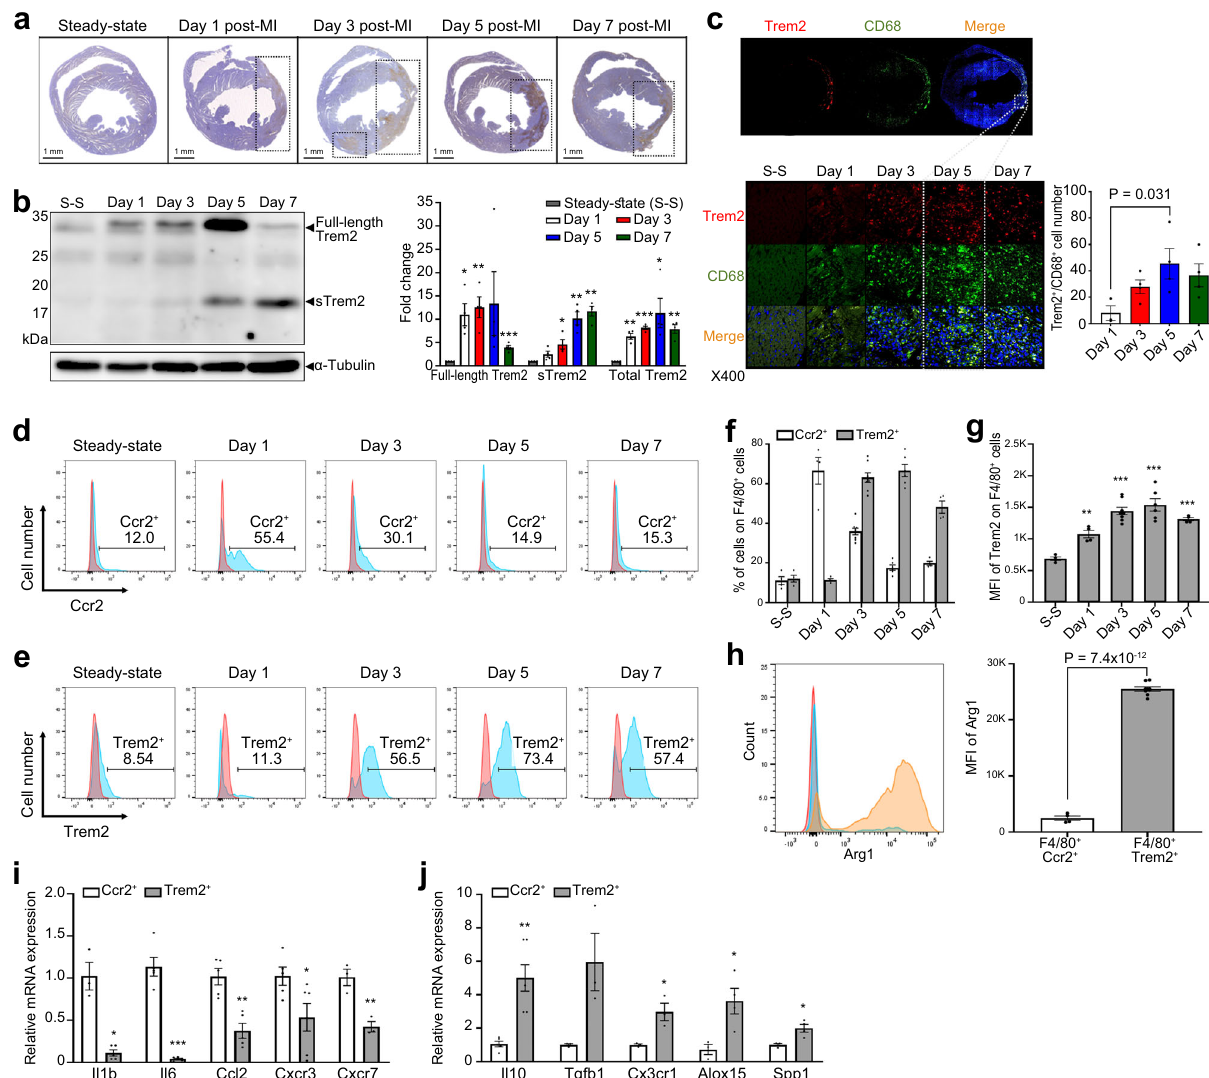
Fig. 5 | Orthogonal validationoftheexpression ofTrem2 in theheart after MI. a Immunohistochemistry showed a gradual increase in the expression of Trem2 over time in the infarcted area after the induction of MI, almost absent in the steady-state. Results are representative of fi ve different samples. b Western blot targeting Trem2 showed two bands: a 32kDa sized one corresponding to the full- length Trem2 protein and an 18kDa sized one corresponding to soluble Trem2 (sTrem2); 50 µ g of infarcted heart tissue proteins were loaded onto each lane. Quantitative comparison of the full-length, soluble form, and total Trem2 expres- sion, respectively ( n =4 for each group). Unpaired two-tailed t-test was used to determine the statistical signi fi cance. * P <0.05, ** P <0.01, *** P <0.001. c Co- localizationassayforTrem2andthemacrophagemarkerCD68intheinfarctedarea accordingtothetime-pointafterMI.Cellswerestainedwiththespeci fi cantibodies anti-Trem2 (red) and anti-CD68 (green). Nuclei were counterstained with DAPI (blue). Quanti fi cation of Trem2 + /CD68 + cells in the infarcted area ( n =3 for day 1 post-MI; n =4fordays2,5,and7post-MI).One-wayANOVAwithtwo-tailedDunnett test was used to determine the statistical signi fi cance. d Comparison of the expression of Ccr2, 1, 3, 5, and 7 days after MI by FACS. e Comparison of the